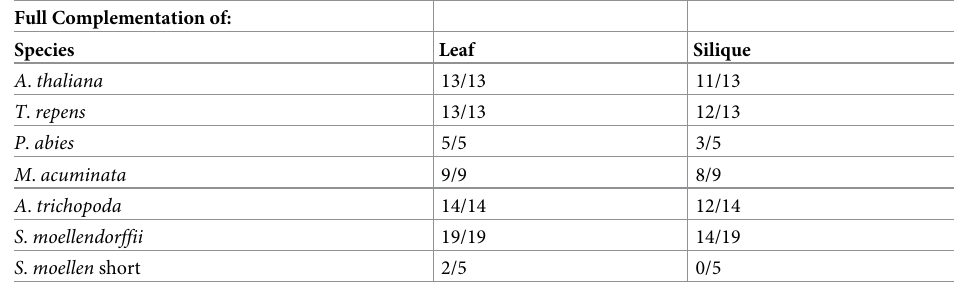
Table 2. Ratios of complemented Arabidopsis Δ ppd plants with constructs containing optimised PPD sequences from various species. Full Complementation of: Species Leaf